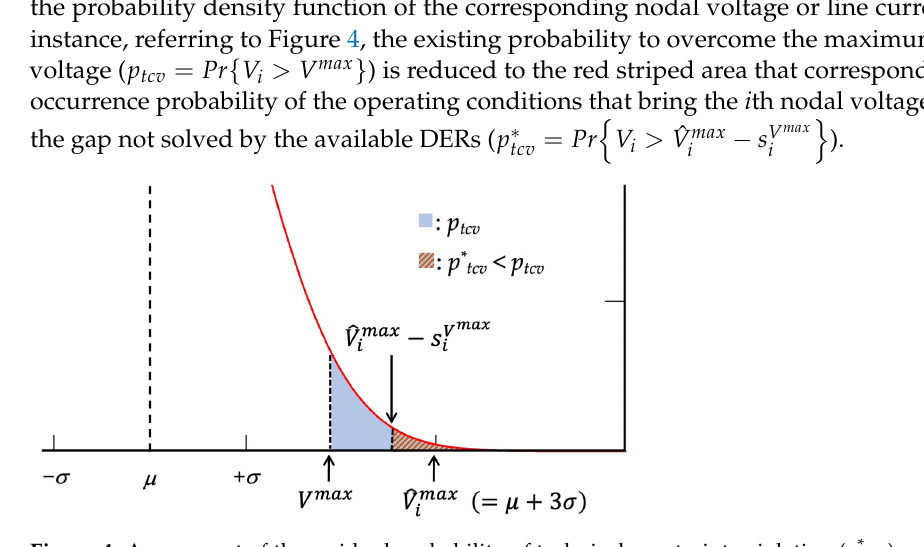
Figure 4. Assessment of the residual probability of technical constraints violation ( p * tcv